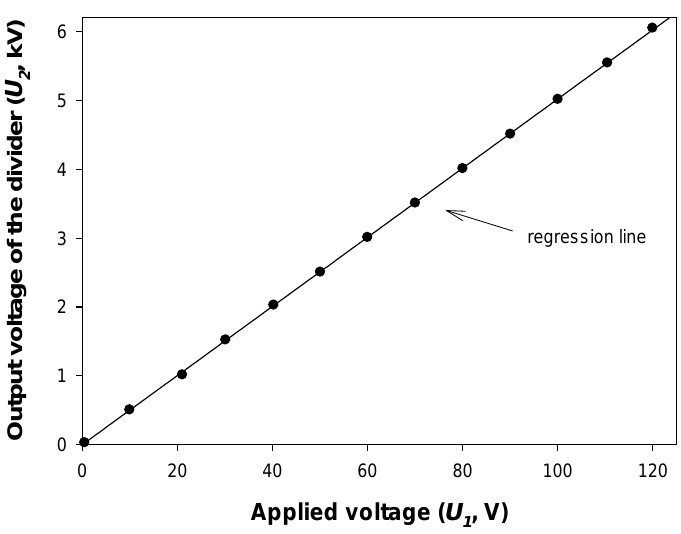
Figure 5. Response of the resistive divider under positive DC supply. Experimental points.